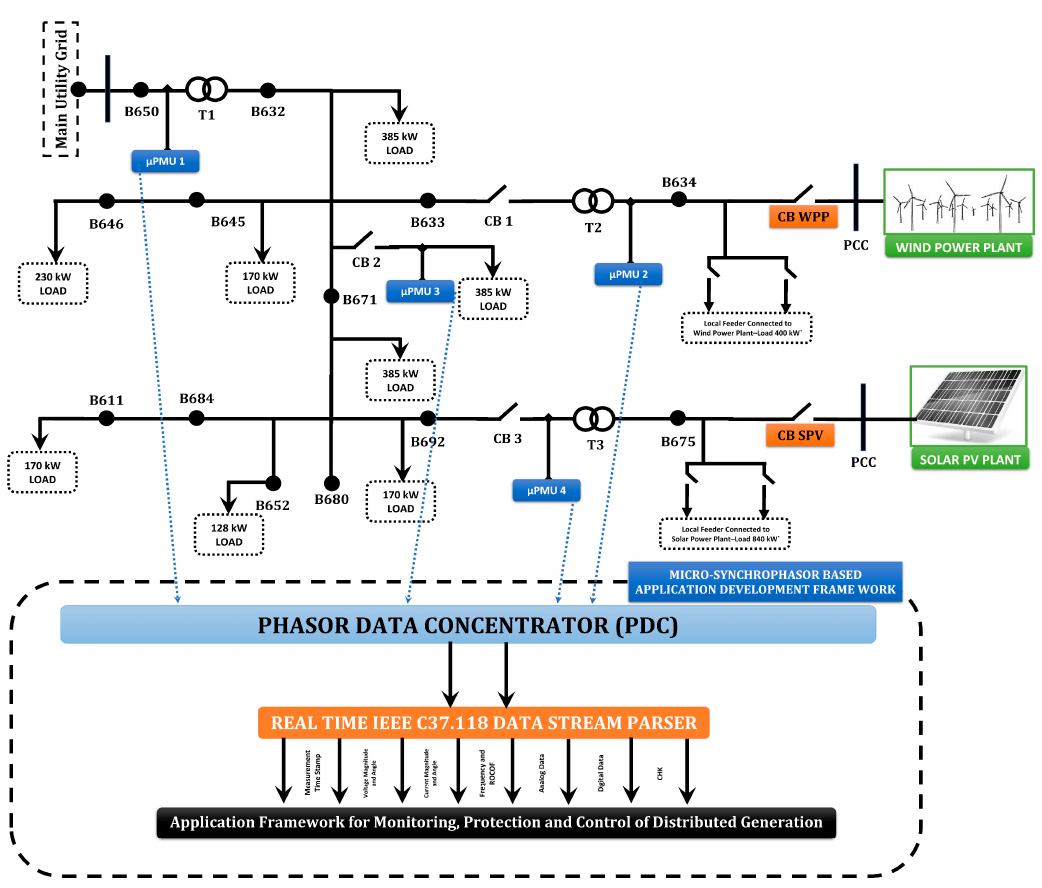
Figure 1. Single line diagram of modified IEEE 13-bus distribution